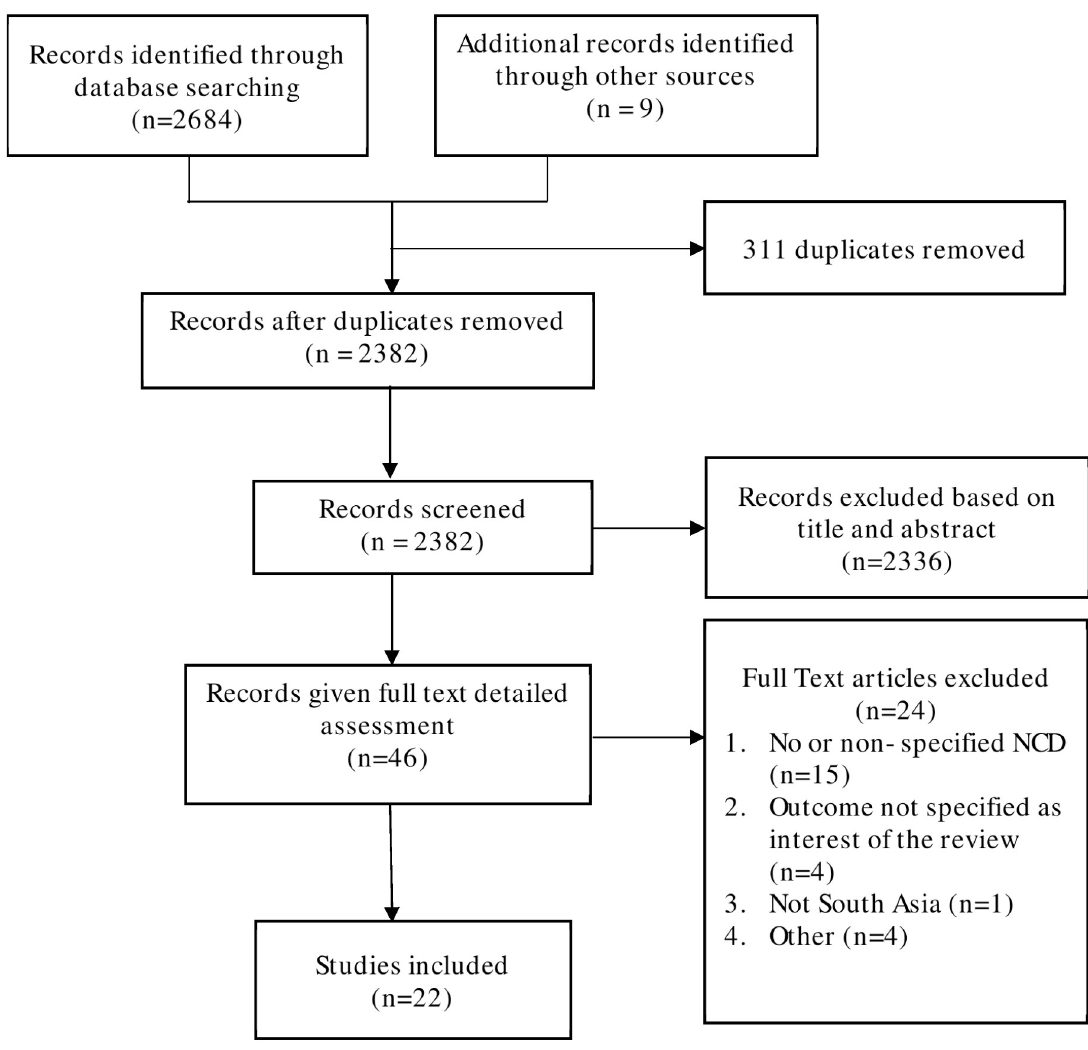
Fig 1. PRISMA flow-chart for systematic review of